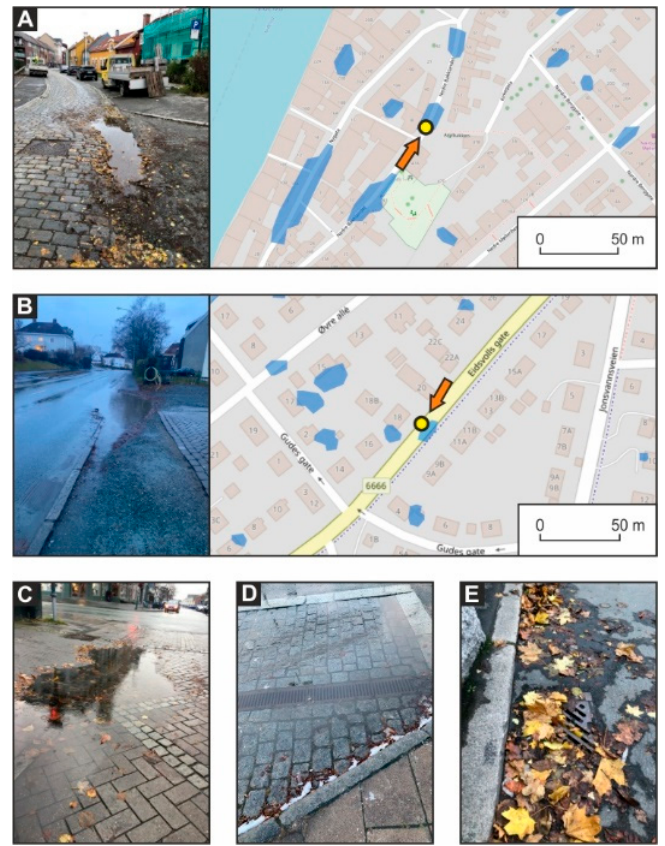
Figure 6. Examples of photos documenting the walking trips made by the participants. Photos ( A , B ) are supported by maps showing their registration positions and the directions from which they were taken (map source: Open Street Map), whereas photos ( C — E ) show puddles of various size and shape and leaves blocking an outlet typically documented by the participants.